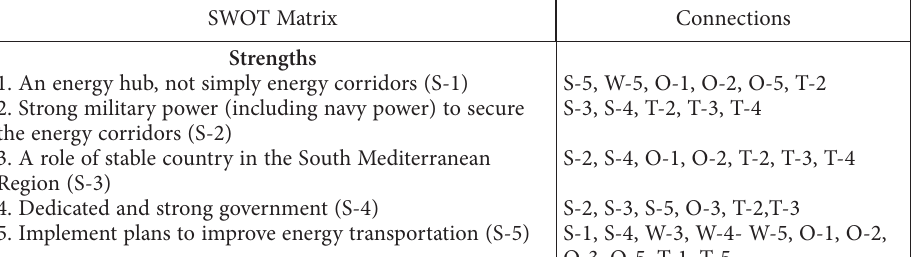
Table 7. SWOT matrix and